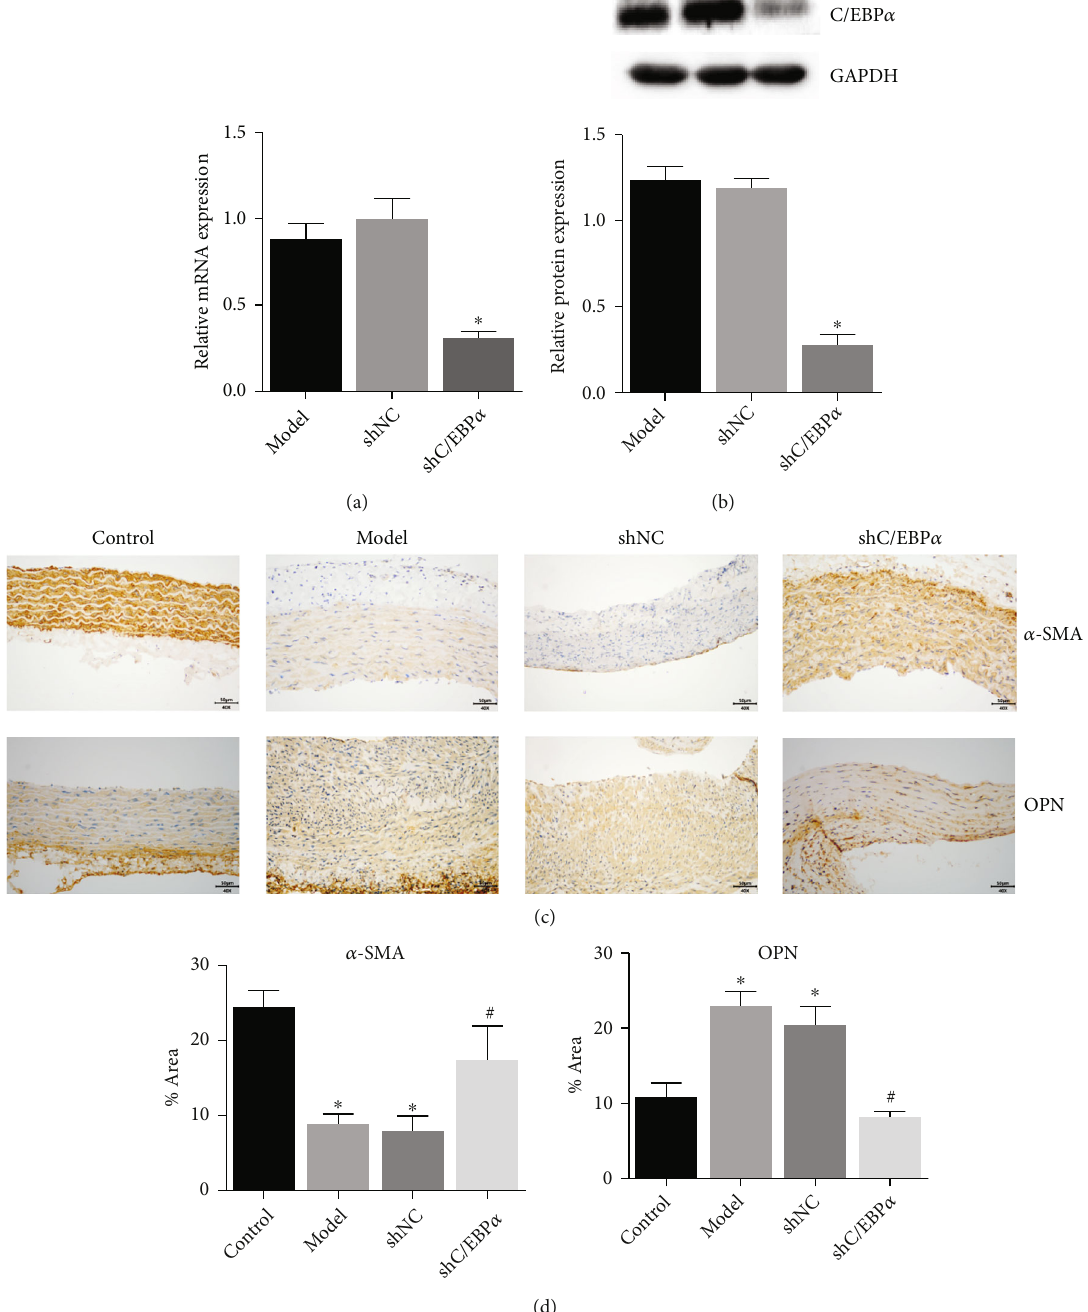
Figure 10: The impact of C/EBP α in AD rats in vivo . C/EBP α expression in vivo was knocked down using C/EBP α shRNA lentivirus in AD rats, and knockdown was con fi rmed at both mRNA level by RT-qPCR (a) and protein level by Western blot (b) ( ∗ P < 0 : 05 vs. model). The representative images (c) and expression levels (d) of α -SMA and OPN in the aortic vessels were determined by the immunohistochemistry ( ∗ P < 0 : 05 vs. control, # P < 0 : 05 vs.